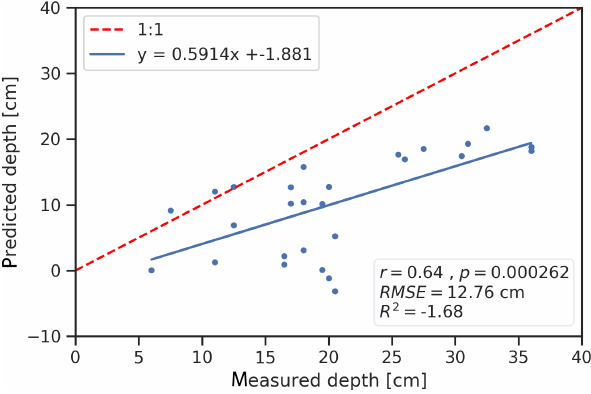
Figure 12. Measured versus predicted water depth for data acquired under overcast conditions on 14 June